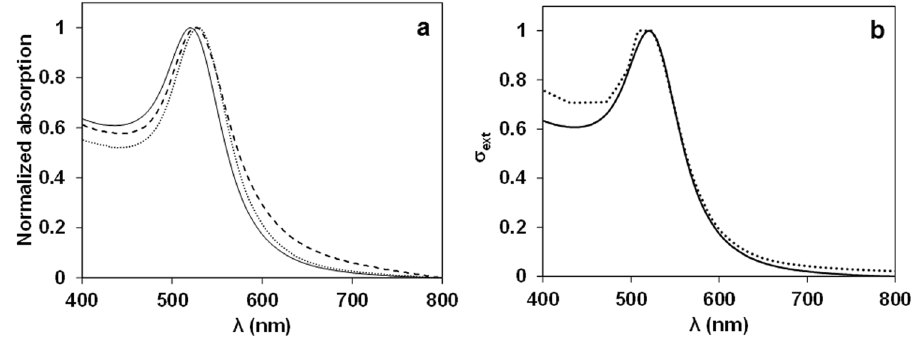
Figure 2. ( a ) Normalized absorption spectra of GNPs dispersed in water (solid curve), GNP-PEG (dashed curve) and GNPSi9 (dotted curve) dispersed in ethanol. A small red shift in the surface plasmon band of the gold is observed due to the higher refractive index of amorphous silica (1.46), compared to that of ethanol (1.36) and water (1.33). ( b ) The extinction spectra of GNPs dispersed in water (dotted curve) corresponds to the sum of the scattering and absorption contributions and can be calculated by the Mie theory (Supporting Information, section S1). The calculated extinction cross section ( σ ext ) agrees with that obtained experimentally for GNPs in water (solid